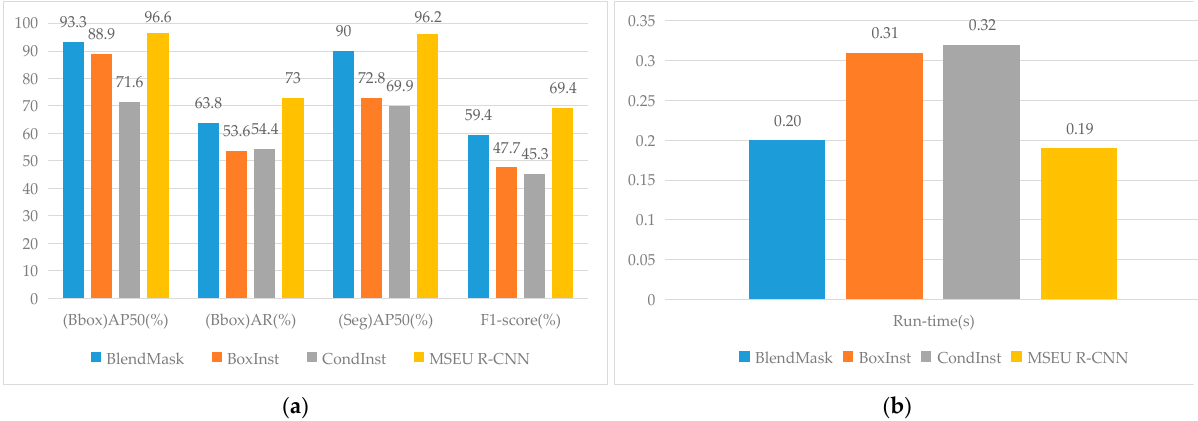
Figure 12. Performance evaluation results of three different models: ( a ) histogram of accuracy; ( b ) histogram of real-time.